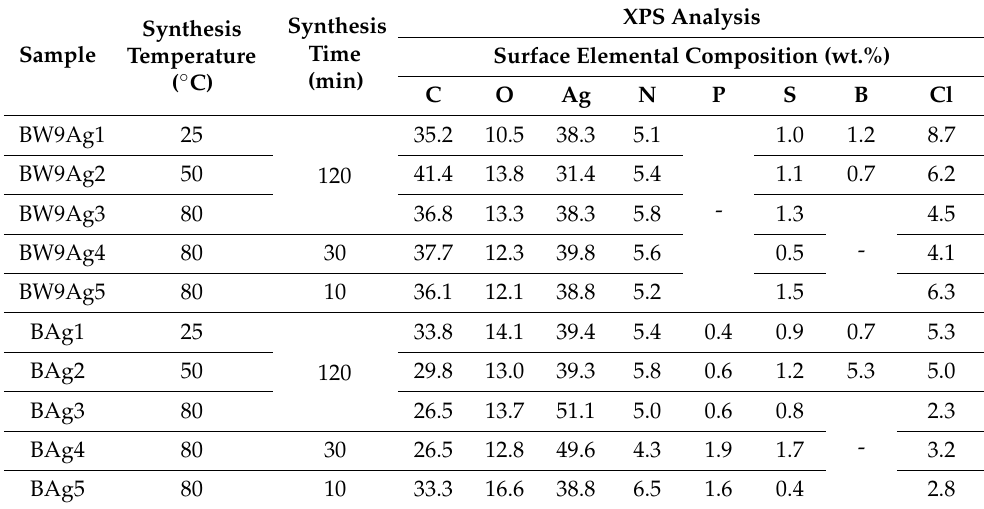
Table 4. Surface weight composition of BW9 and B nanocomposites obtained from XPS